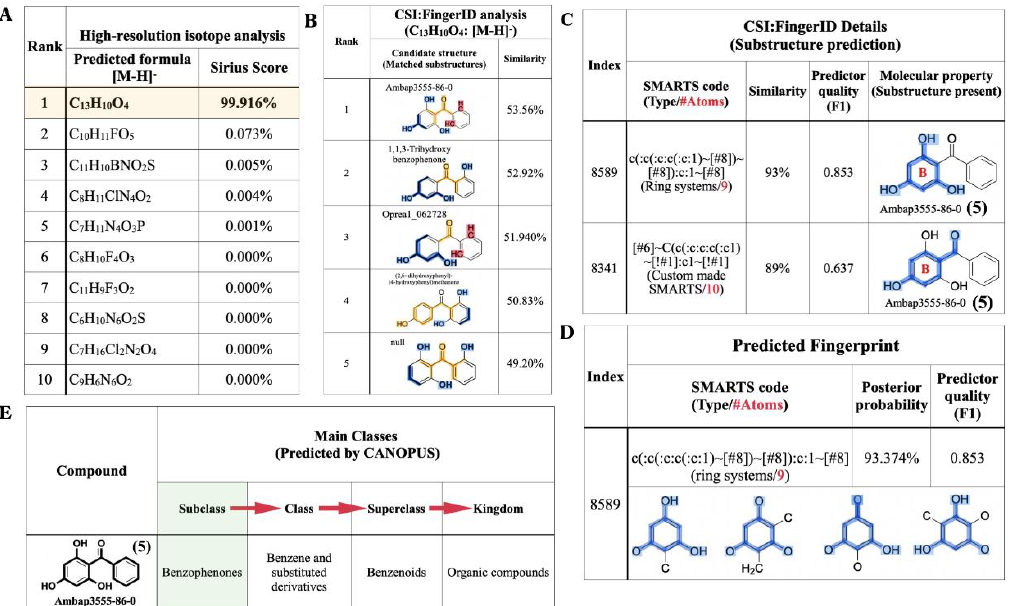
Figure 7. The molecular formula and structural annotation of the query metabolite ( m / z 229.0496 [M − H] − ), which was produced by clones carrying pETDuet-BadA-GmBPS. ( A ) A high-resolution isotope pattern analysis clearly showed that the molecular formula of the query was well annotated as C 13 H 10 O 4 (99.916%); ( B ) The CSI:FingerID web service revealed that the compound (C 13 H 10 O 4 ) was elucidated as 2,4,6-TriHB ( 5 ) (named Ambap3555-86-0). ( C ) Phloroglucinol (1,3,5-trihydroxybenzene) and the B-ring attached to the carbonyl group were the substructures predicted to be present in the query metabolite. ( D ) The substructures corresponding to phloroglucinol were detected in the CSI:FingerID training set. ( E ) CANOPUS, the compound classification tool, reveals that our query subject belonged to the class benzophenones, which are defined as the organic compounds containing two phenyl groups attached via a ketone bridge. The present substructures in the query metabolite were highlighted as intense blue lines .